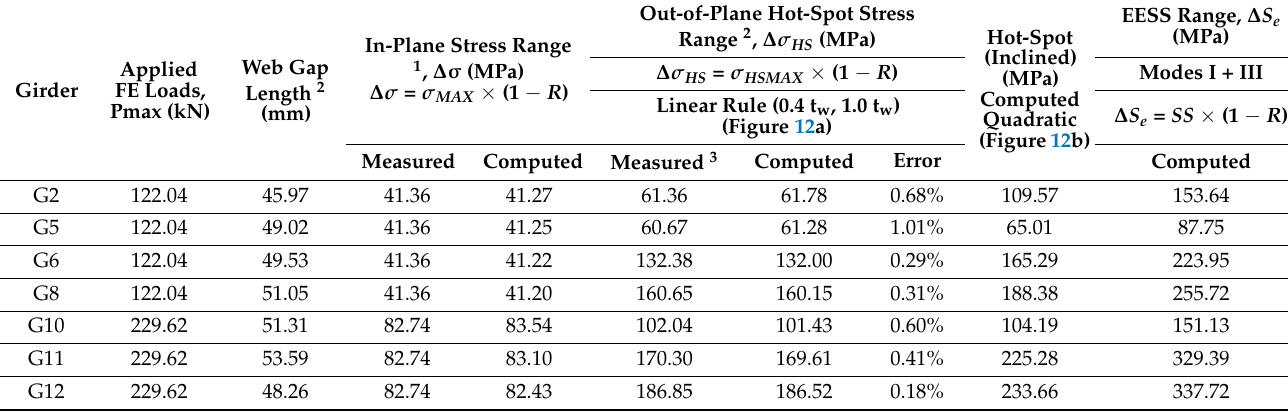
Table 3. Nominal and secondary stresses of the calibrated local FE